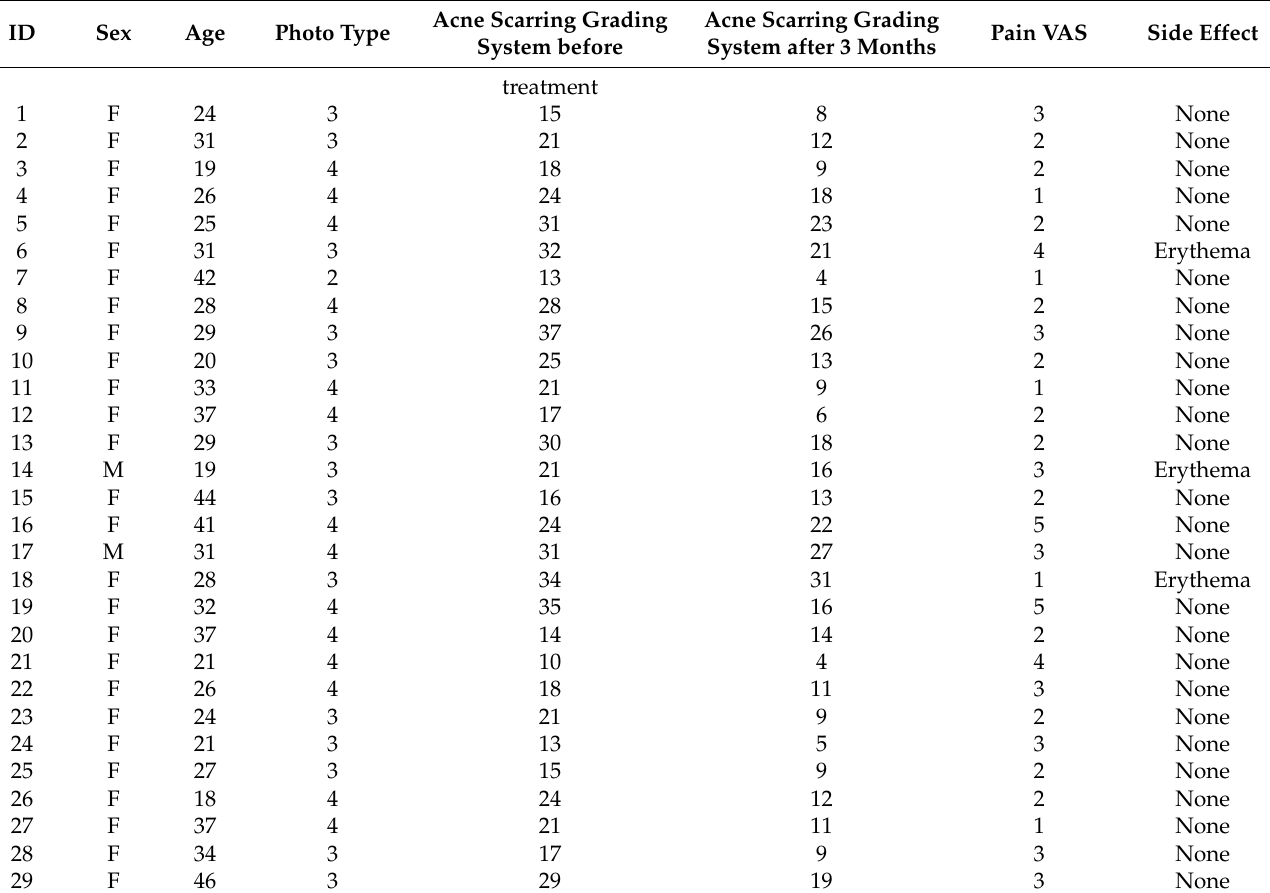
Table 2. Patients’